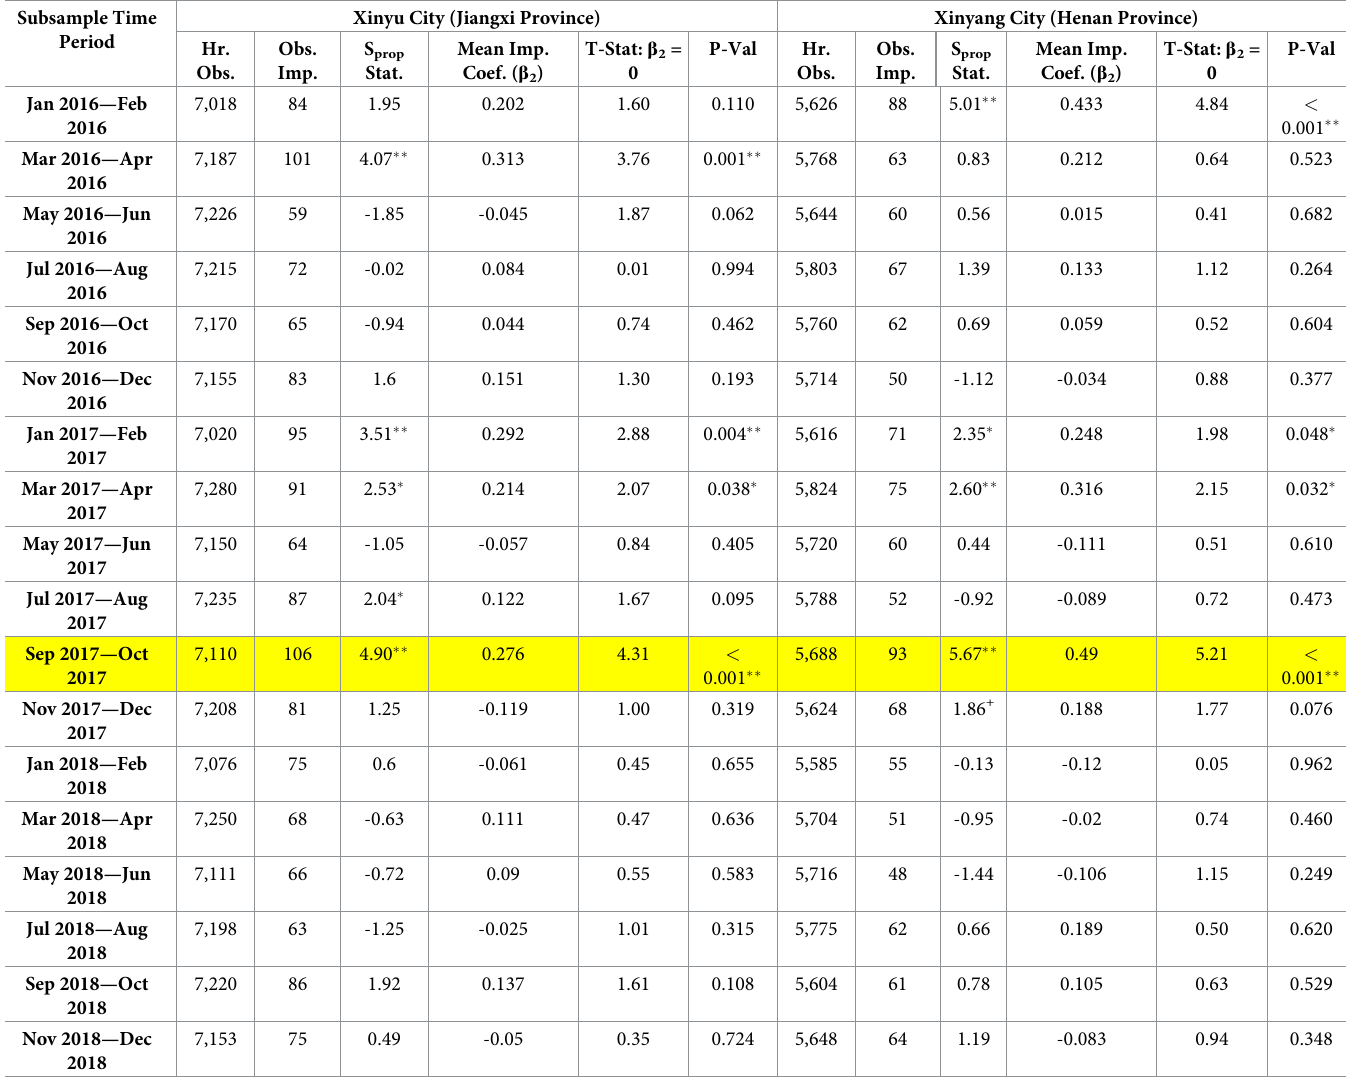
Table 5. Results for stations in China where local officials were caught misreporting data. Subsample Time